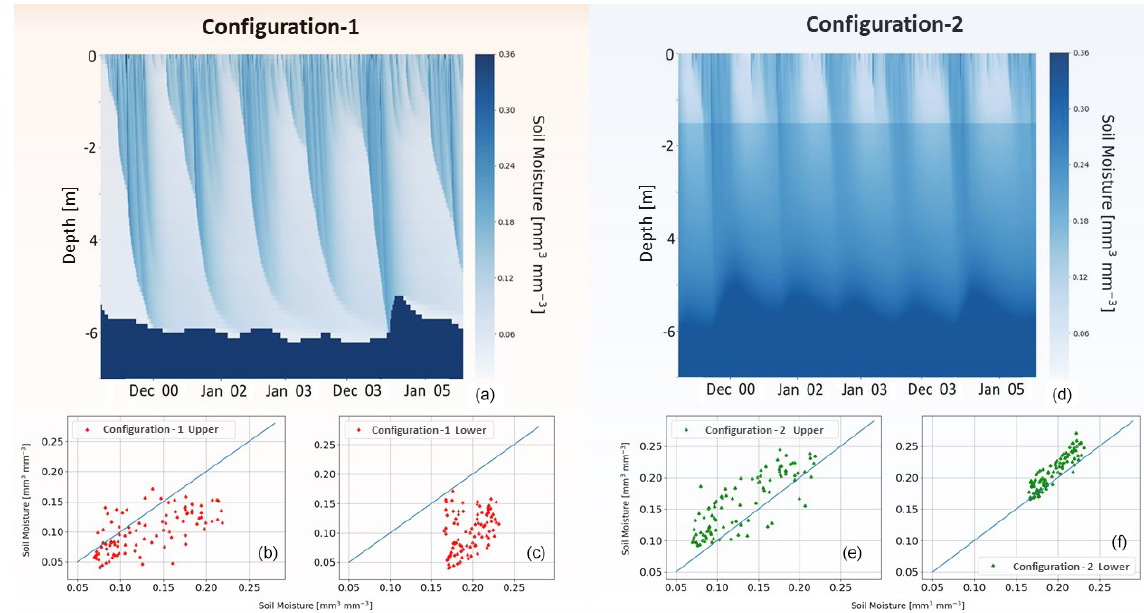
Figure 5. Temporal evolution of the SM contents and WT levels. Panels (a, d) show the entire modelled column, including the fluctuation of the WT (i.e. the dark blue area). Panels (b, e) represent the modelled and observed water content for the upper soil (averaged over 0–300mm depth). Panels (c, f) show these results for the lower soil (averaged over the interval 1500–1800mm depth).